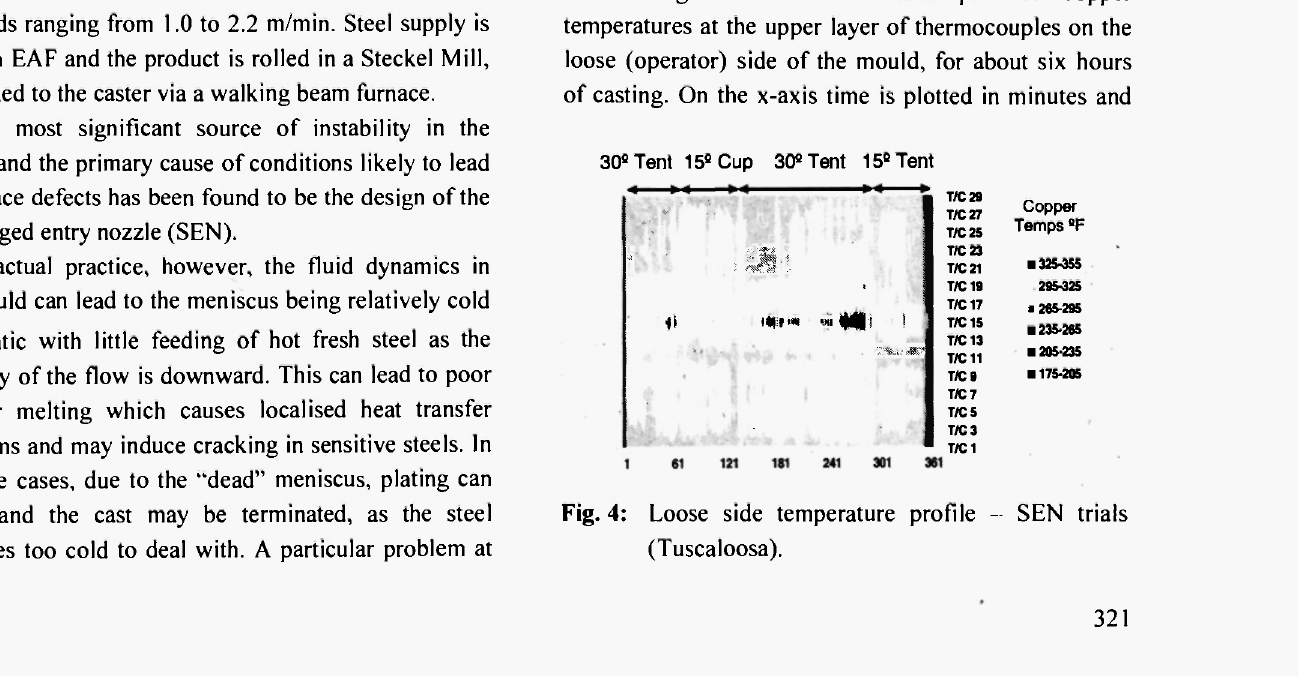
temperatures at the upper layer of thermocouples on the loose (operator) side of the mould, for about six hours